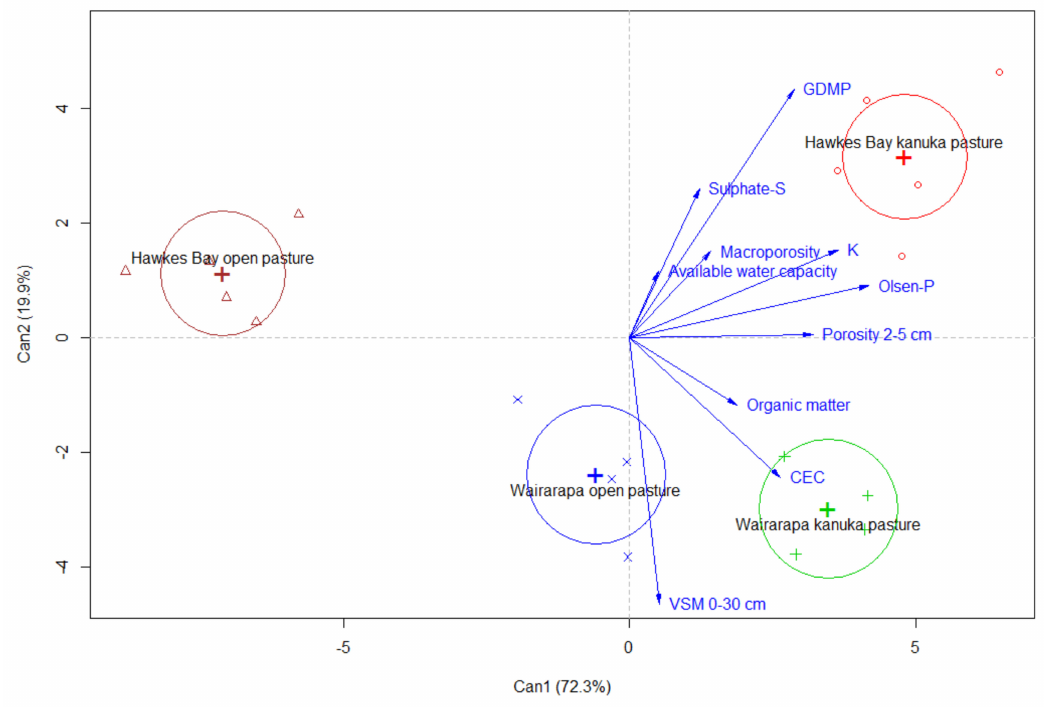
Figure 3. Canonical variate analysis showing which variables best explain treatment and site dif- ferences. GDMP = Green dry matter production. P = phosphorus. S = Sulfur. K = potassium. CEC = cation exchange capacity. VSM = volumetric soil